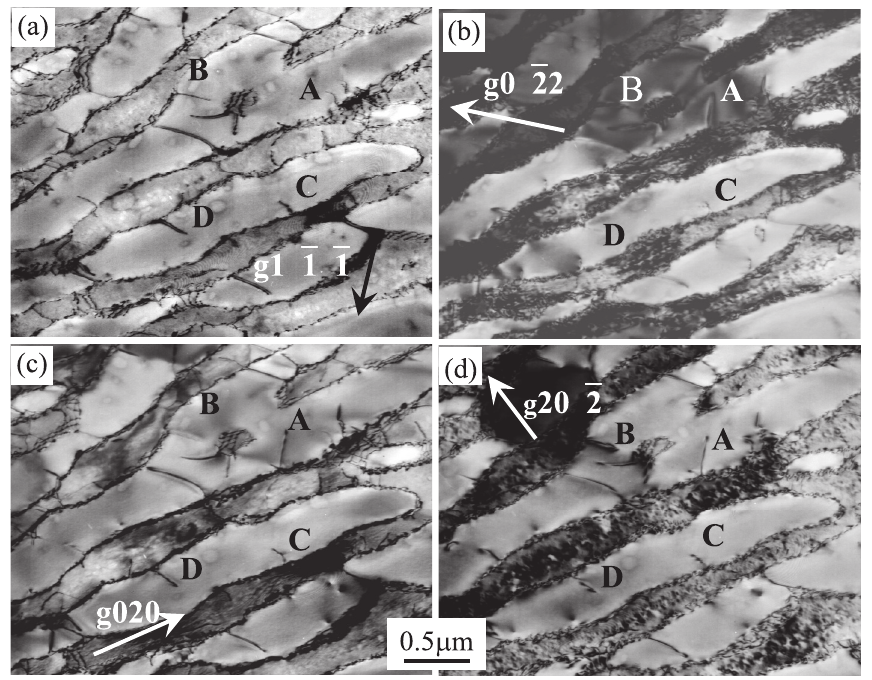
Fig. 8: Dislocation configuration within the g′ phase after the alloy crept for 92 h up to fracture at 1040 °C/137 MPa. (a) g = 1 1 1, (b) g = 020, (c) g = 1 31, (d) g = 1